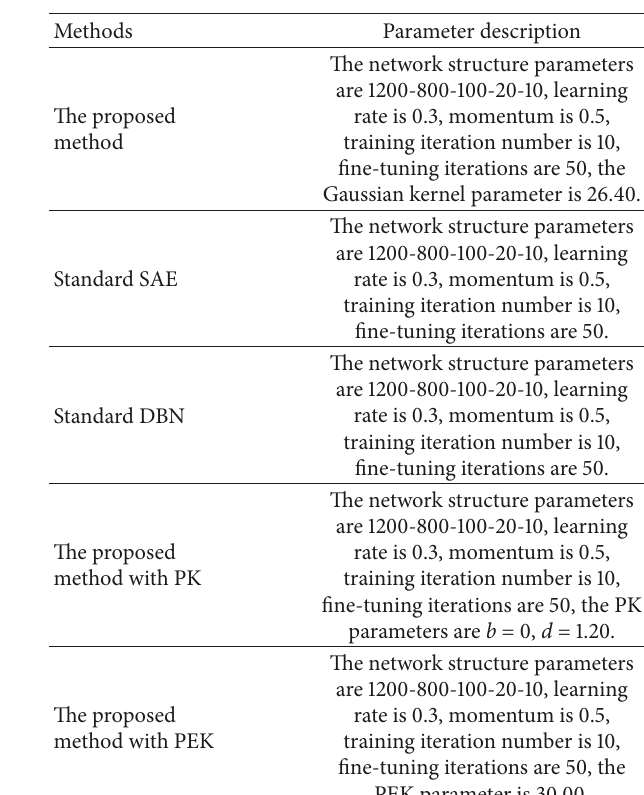
Table 2: Parameter description of the five methods in Experiment